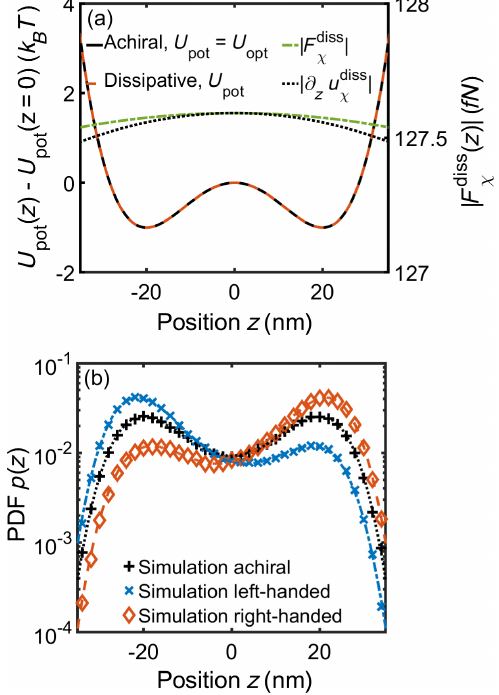
FIG. 7. (a) A dissipative chiral coupling is induced by the chiral nanosphere ( χ = α ¼ 5% ) for h þ ¼ − h − in the two beams and the polarization settings detailed in Fig. 3. The angle formed between the polarization axes of the beams and their helicities are fixed so as to lead to the generation of a chiral flux Φ ð q; z Þ — and zero chiral density — with the same achiral optical potential energy ð q; z Þ as for an achiral environment [in black, same as density U opt in Fig. 3(a)] again calculated at q ¼ 0 . Our chiral dipole now couples to the chiral optical environment through Im ½ χ (cid:3) with chiral dissipative forces F diss χ ð q; z Þ that are opposed for opposite signs in Im ½ χ (cid:3) — the same sign inversion appears if, instead of changing dipole enantiomers, one changes electromagnetic field enantiomorphs. Note that in the paraxial approximation of the model with Δ l ≪ z R , we have Δ F diss χ ð q; z Þ ≪ F diss χ ð q; z Þ ; see the main text. Here, we plot the profile of a second-order develop- ment of F diss χ ð q; z Þ (black line) with the associated scale on the right-hand side of the graph. Because the dissipative chiral force is nonconservative, it does not contribute to the potential free- energy surface as it is the case for the reactive chiral coupling. (b) The influence of the chiral dissipative force is seen on the modified steady-state probability density function of the chiral dipole in the bistable trap, shifted in the direction of the force for both our one-dimensional model (lines) and three-dimensional simulations (symbols); see details in Appendix E. This modified PDF reveals the strong chiral discriminating action of F diss χ ð 0 ; z Þ with respect to the two local maxima at z A and z C . We give in the main text the thermodynamics interpretation of this